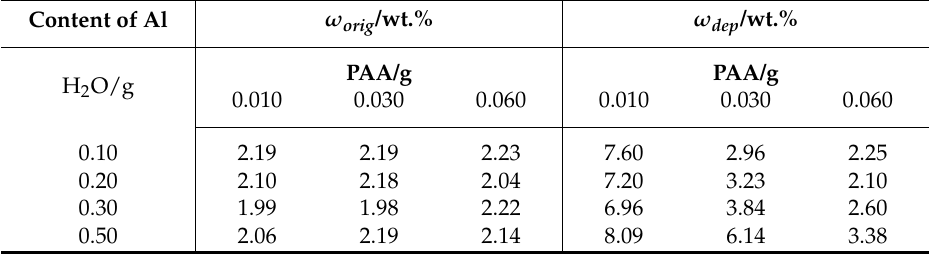
Table 2. Al contents (wt.%) of the samples before and after spraying tests ( − 30 kV). Content of Al ω orig /wt.% ω dep /wt.% PAA/g PAA/g H 2 O/g 0.010 0.030 0.060 0.010